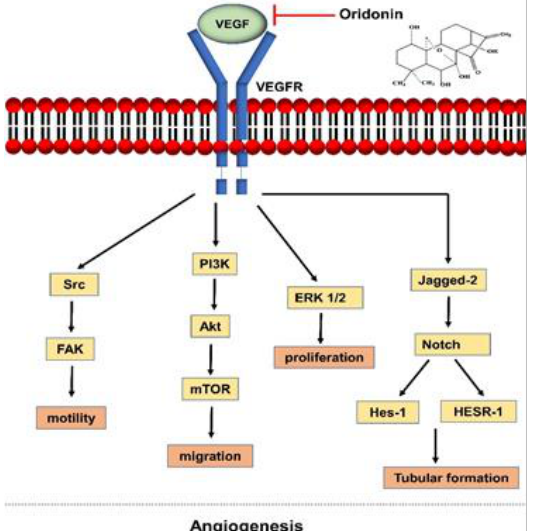
Figure 2. The effects of oridonin on angiogenesis. Oridonin inhibits angiogenesis by blocking the activation of VEGF and its downstream signaling pathways such as Src, PI3K, ERK 1/2, and Notch in endothelial cells. Abbreviations: vascular endothelial growth factor (VEGF); vascular endothe- lial growth factor receptor (VEGFR); focal adhesion kinase (FAK); phosphatidylinositol 3-kinase (PI3K), mammalian target of rapamycin (mTOR); extracellular signal-regulated protein kinase (ERK). 3. Oridonin in EMT